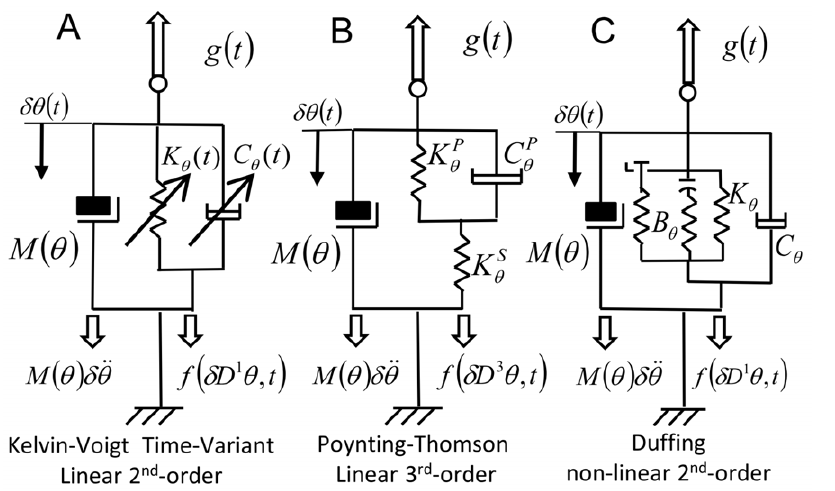
Figure 2. Mechanical models used in the simulations. A) Time-variant second-order viscoelastic linear system (Kelvin-Voigt). B) third-order viscoelastic linear system (Poynting-Thomson). C) Time-invariant second-order cubic viscoelastic system (Duffing). The schematics highlight the different force fields of the D’Alembert equation (2) when the internal forces generated by the dynamics are negligible. In the figure, each force field is dependent to the mechanical elements that generate it.